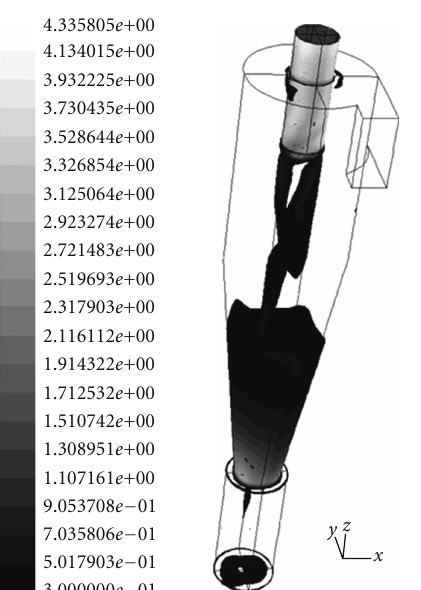
Figure 7: Particles volume fraction near the cyclone wall (0.01kg/m 3 ).